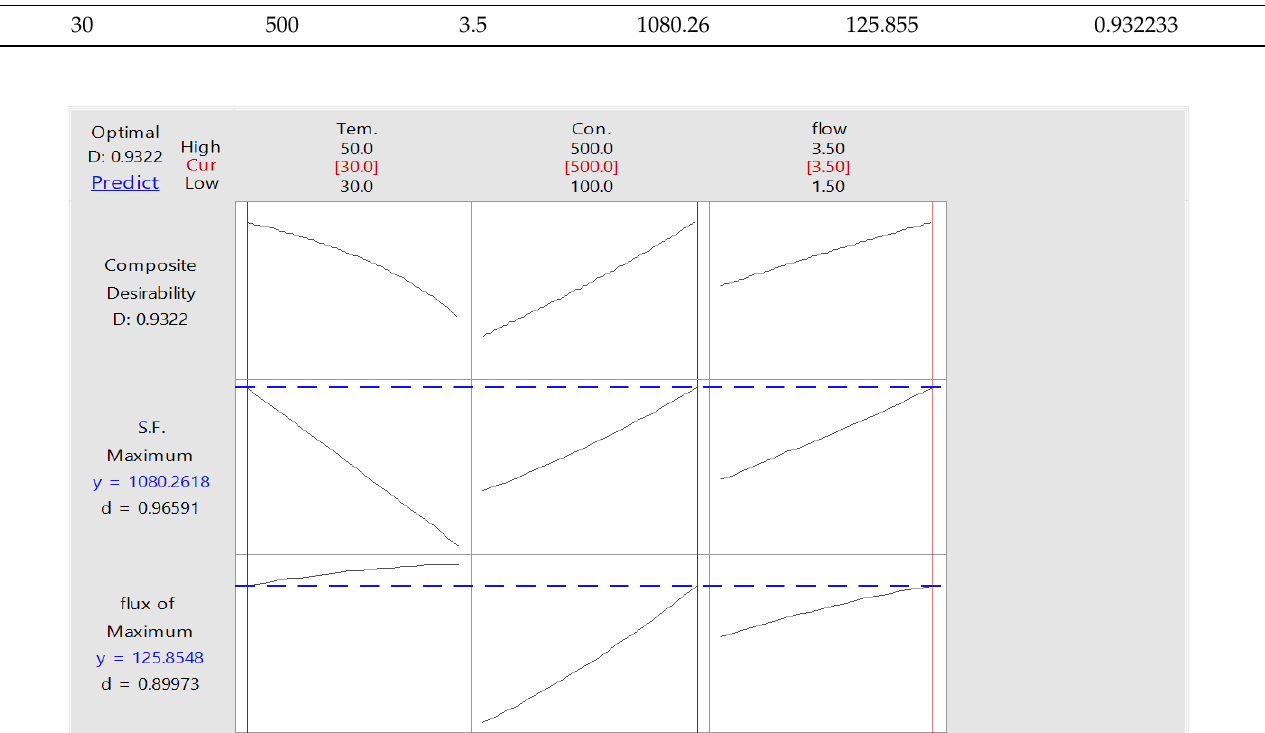
Figure 6. Optimization plot for toluene flux and S.F. for toluene – water solution .